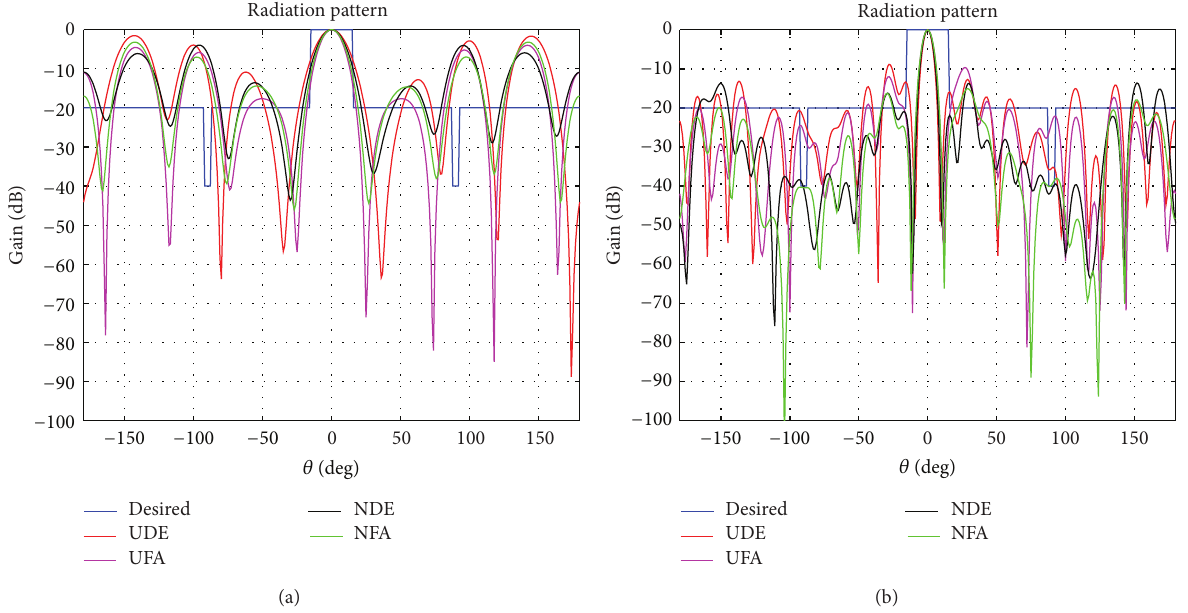
Figure 3: Radiation pattern for (a) 𝑁 × 𝑀 = 2 × 4 , (b) 𝑁 × 𝑀 = 4 × 4 .